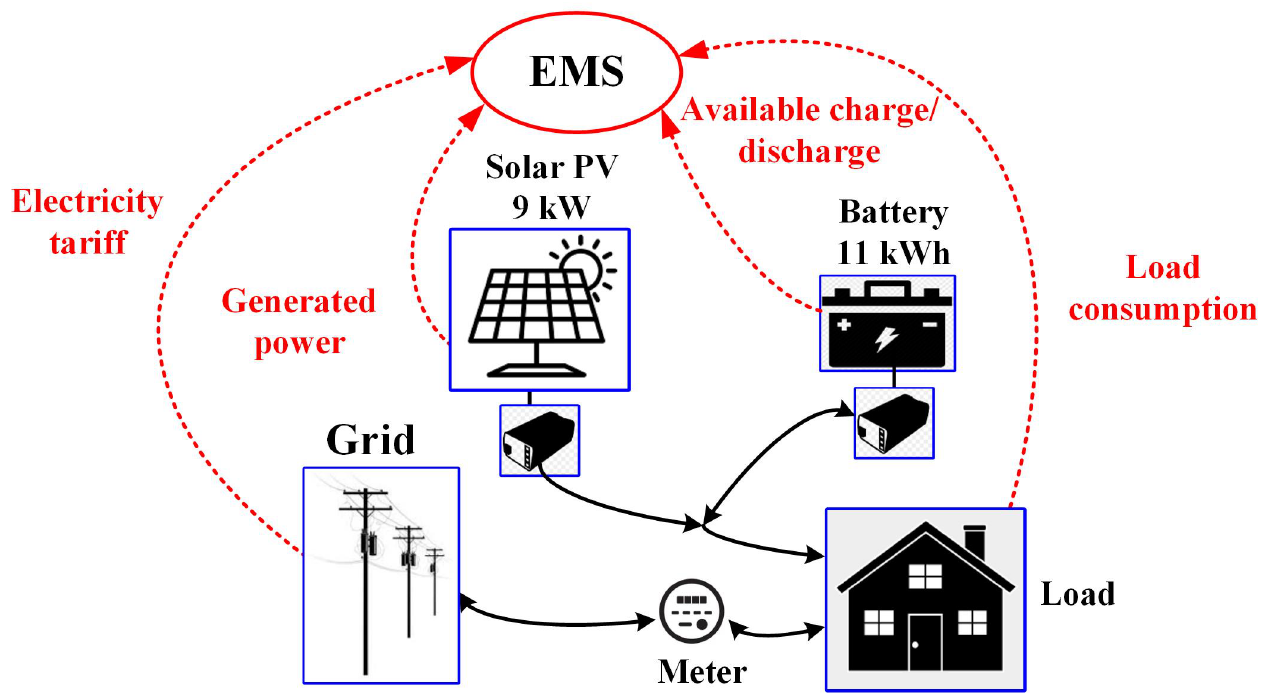
Figure 1. System configuration of the grid-connected home with PV-battery and the EMS. Table 2. The four options based on electricity tariffs for electricity buying and selling.